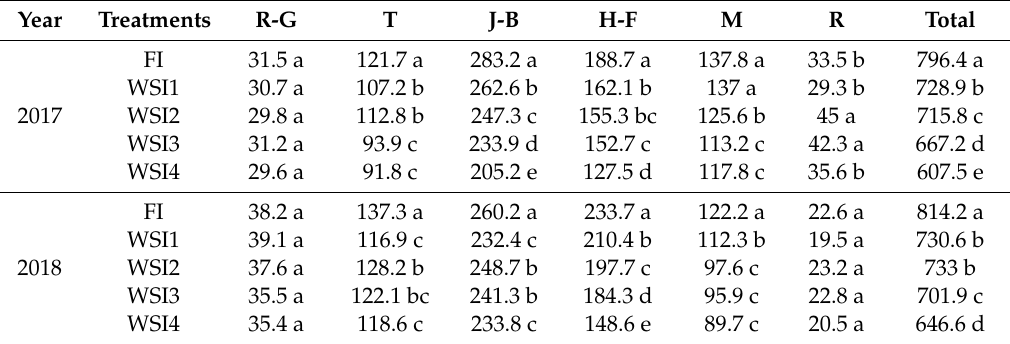
Table 2. The evapotranspiration of di ff erent irrigation regimes in di ff erent growth stages.